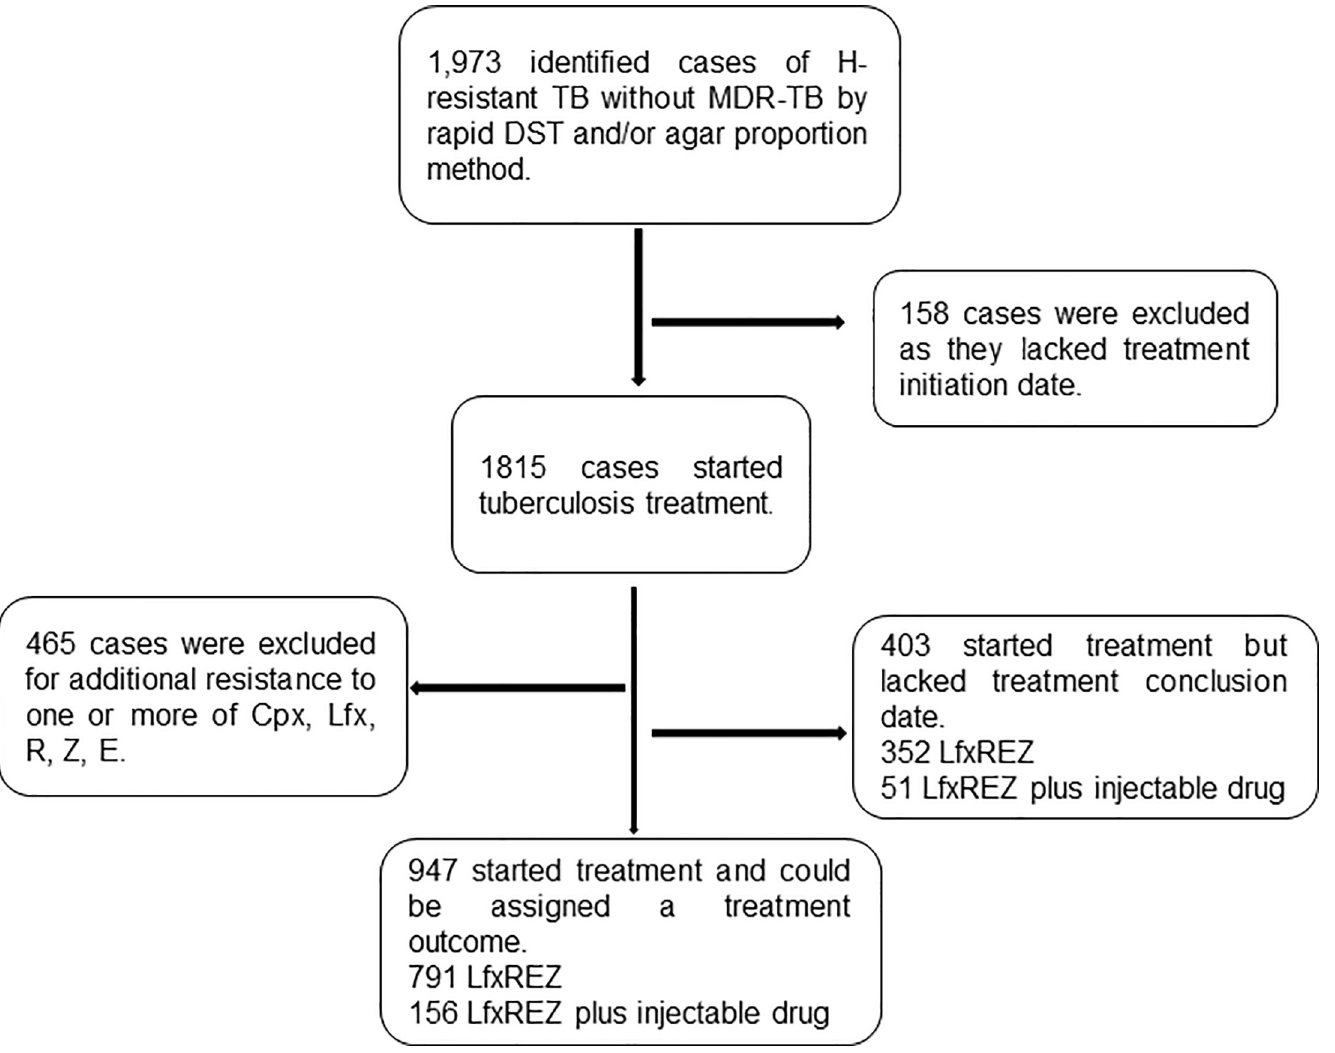
Fig 1. Flowchart for case